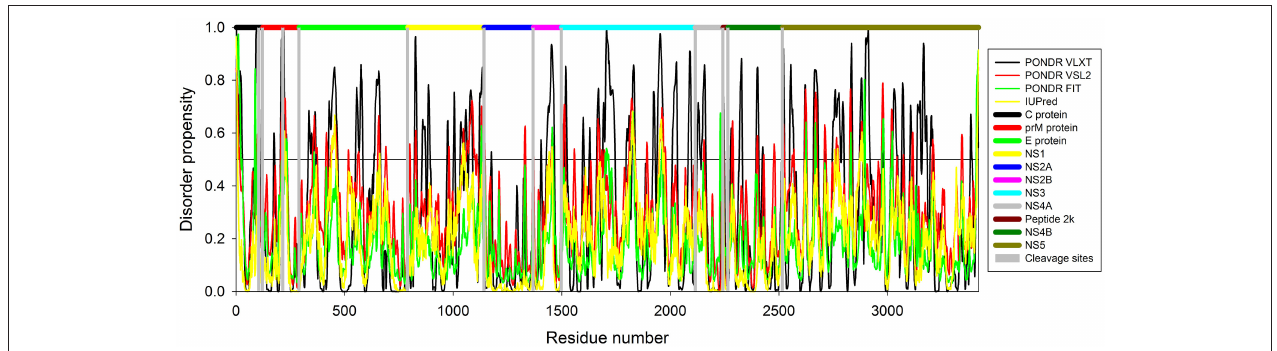
FIGURE 2 | Intrinsic disorder predisposition of Zika virus polyprotein (Q32ZE1). Disorder propensity is evaluated by PONDR ® VLXT (black line), PONDR ® VSL2 (red line), PONDR ® FIT (green line) and IUPred (yellow line). Colored bars at the top of plot shows localization of the individual proteins. Corresponding cleavage sites leading for the generation of mature individual proteins are shown by gray bars. Disorder scores above the threshold 0.5 characterize residues/regions predicted to be disordered.